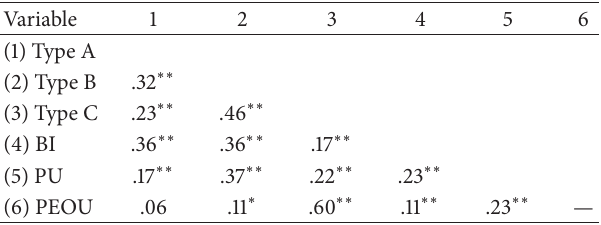
Table 7: Mediation analysis of customers’ data.